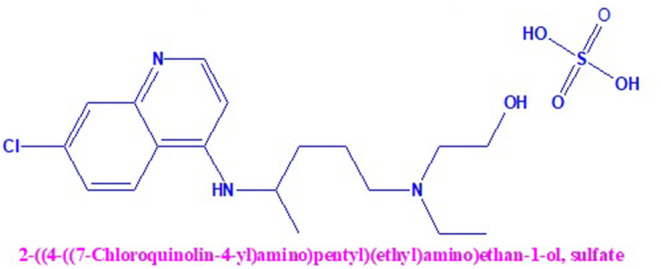
Chemical structure of Hydroxy chloroquine sulfate.